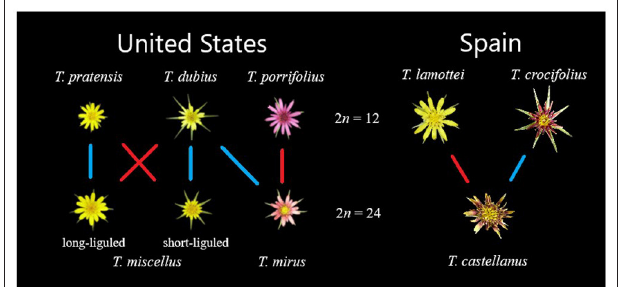
FIGURE 1 | Relationships among the Tragopogon diploids and polyploids. US species are left of the chromosome counts and Spanish species are on the right. Diploids are aligned along the top row and polyploid offspring are along the bottom row. Colored lines indicate whether the diploid serves as the maternal or paternal parent for the corresponding polyploid, where blue is paternal and red is maternal.